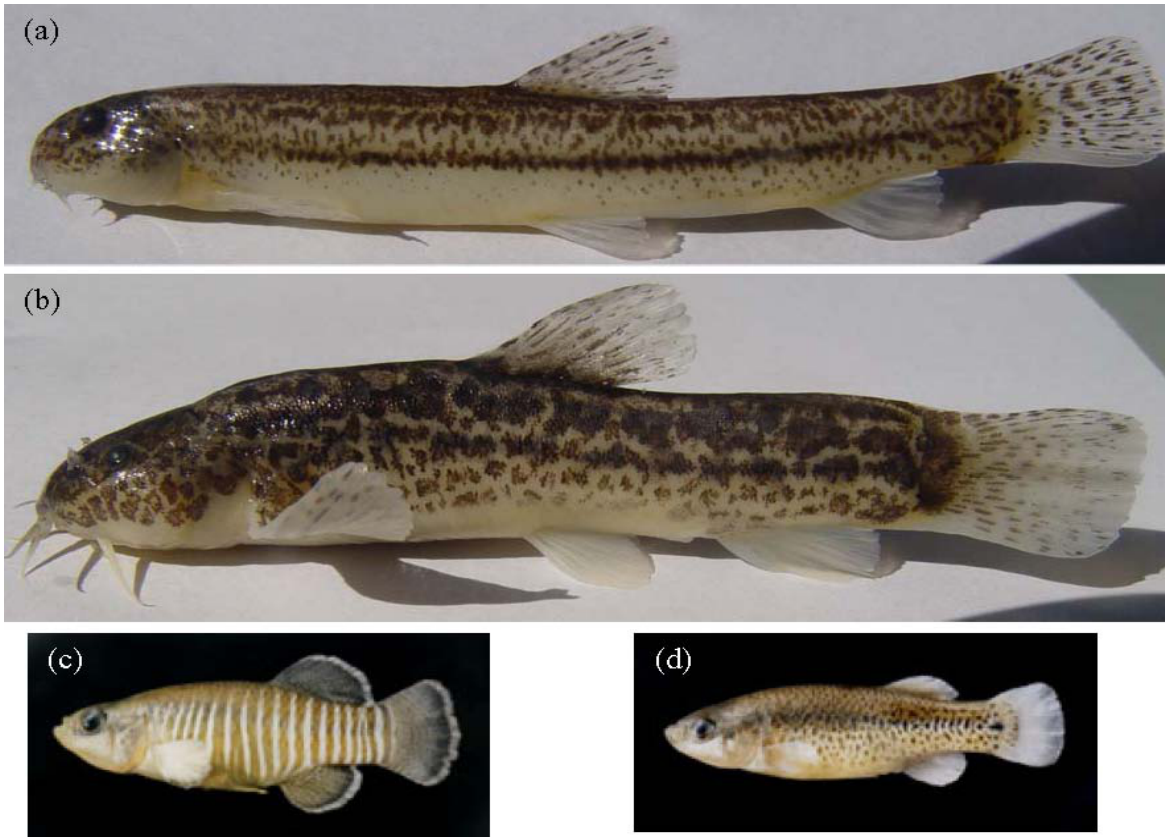
F IG . 3. - Three endemic fishes of Ghadamgah spring-stream system a, Cobitis linea (Cobitidae); b, Seminemacheilus tongiorgii (Balitoridae); c, male Aphanius sophiae ; d, female A. sophiae